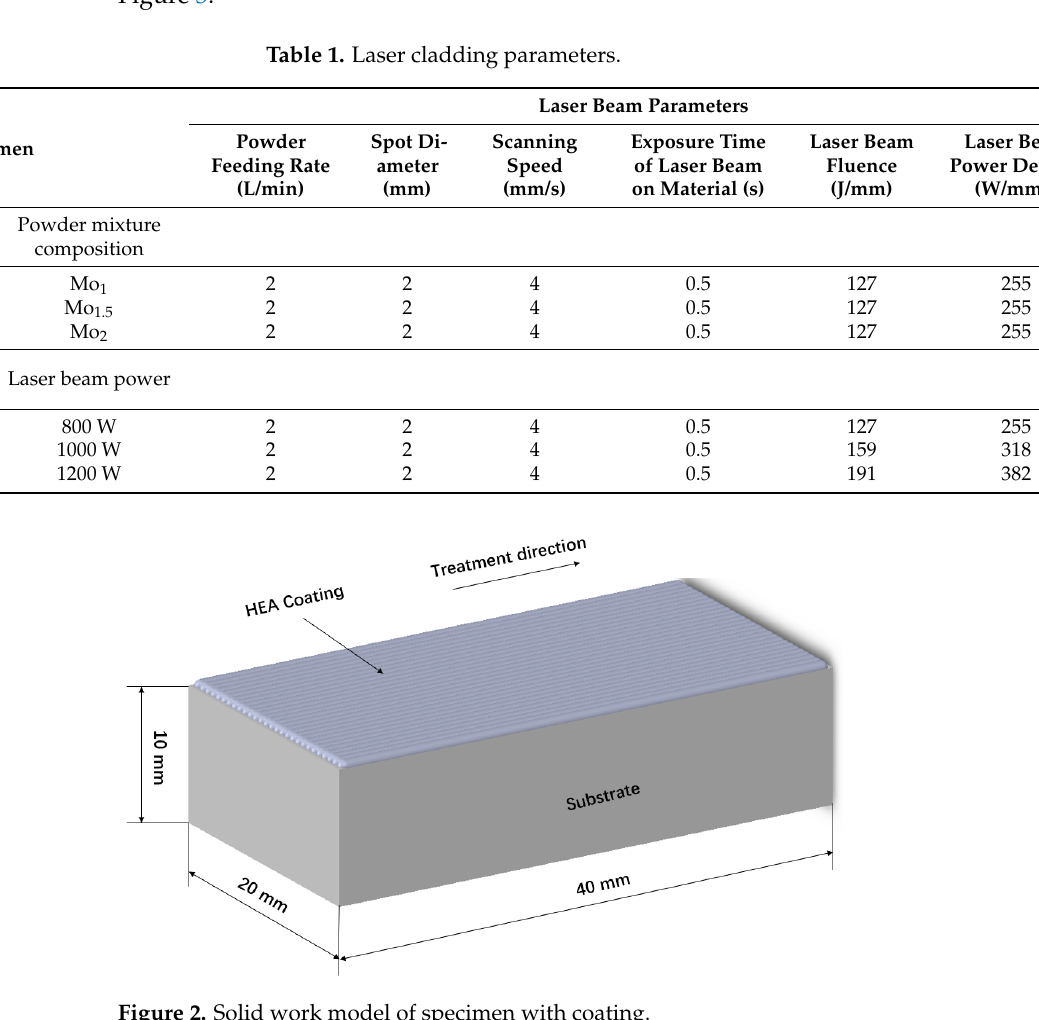
Figure 2. Solid work model of specimen with coating.